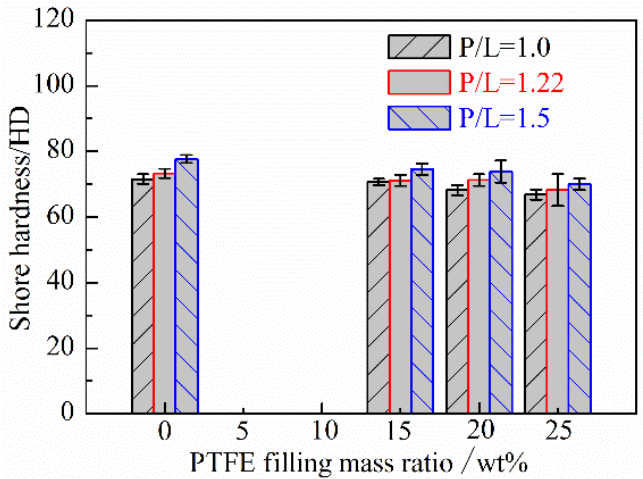
Figure 5. The effect of the filling mass ratio of PTFE and P/L ratio on the shore hardness of PMMA based composites.